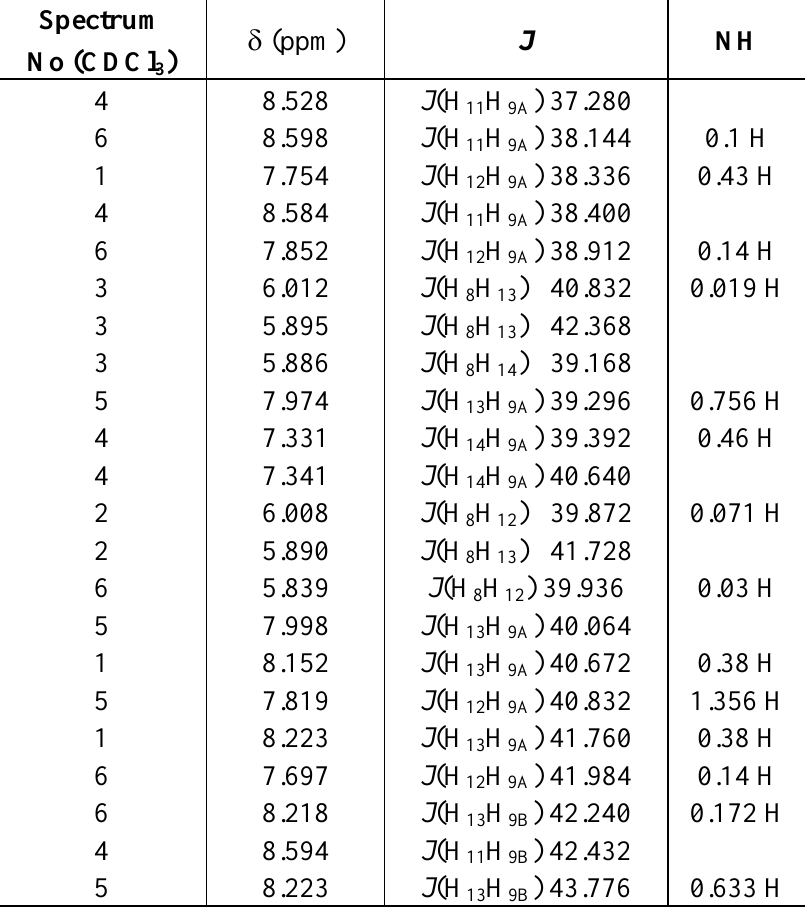
Table 8 . The 1 H-NMR chemical shifts δ [ppm] from TMS and the 1 H- 1 H long – range coupling constants [Hz] of